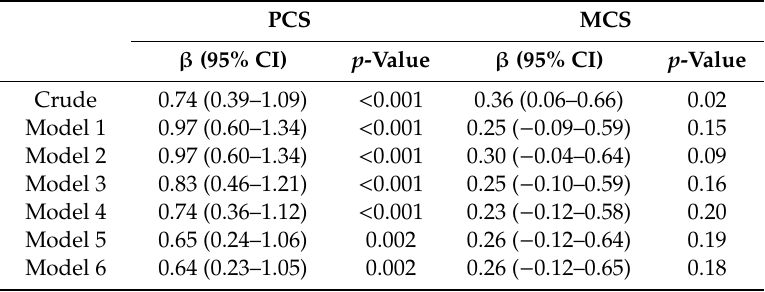
Table 3. Association of protein intake (per 10 g / d increment) with Quality of